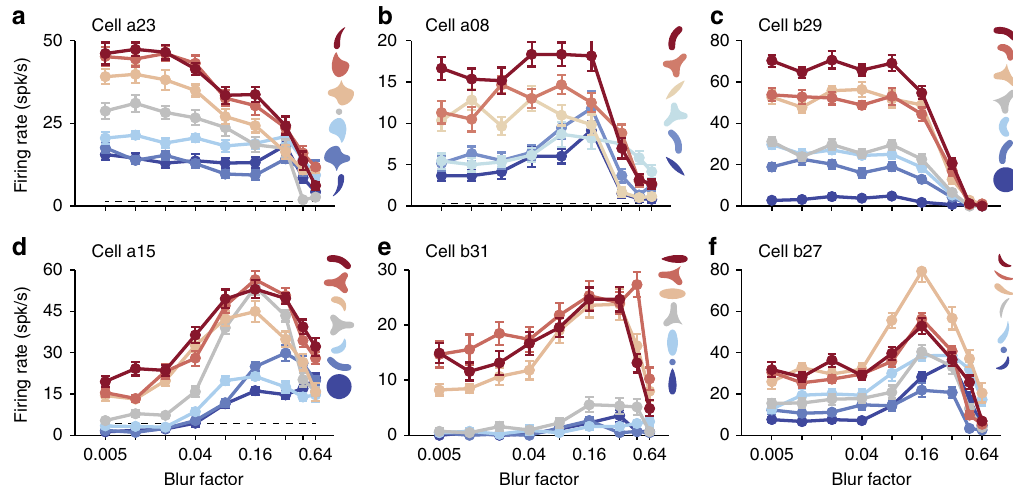
Fig. 2 Shape-selective V4 neurons are tuned for blur. a – f For each neuron we plot the mean responses ( y -axis) to several stimuli as a function of the magnitude of blur factor ( x -axis, β ). Line color indicates shape identity and is ordered from preferred (red) to non-preferred (blue) stimuli for each neuron based on responses to the sharp versions of each stimulus ( β = 0.005). Error bars indicate s.e.m. a Responses of an example V4 neuron that was strongly selective to sharp stimuli, i.e., β = 0.005; responses declined gradually to baseline levels (dashed line) as blur magnitude was increased. b , c Two additional examples that also exhibited a monotonic decrease in responses with increasing blur. Unlike a , these neurons maintained their response level across low blur levels, sharply declining to baseline beyond a critical blur factor ( β ≈ 0.16). d – f Example V4 neurons that respond best at intermediate levels of